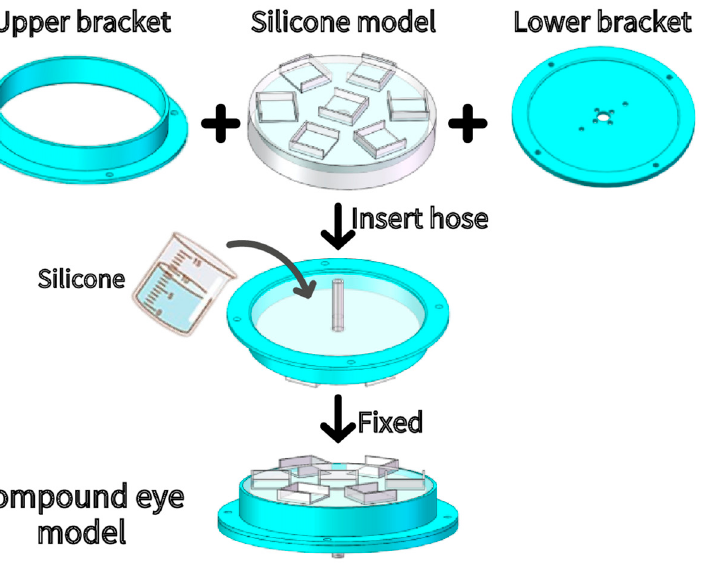
Figure 11. Sam group transfer.